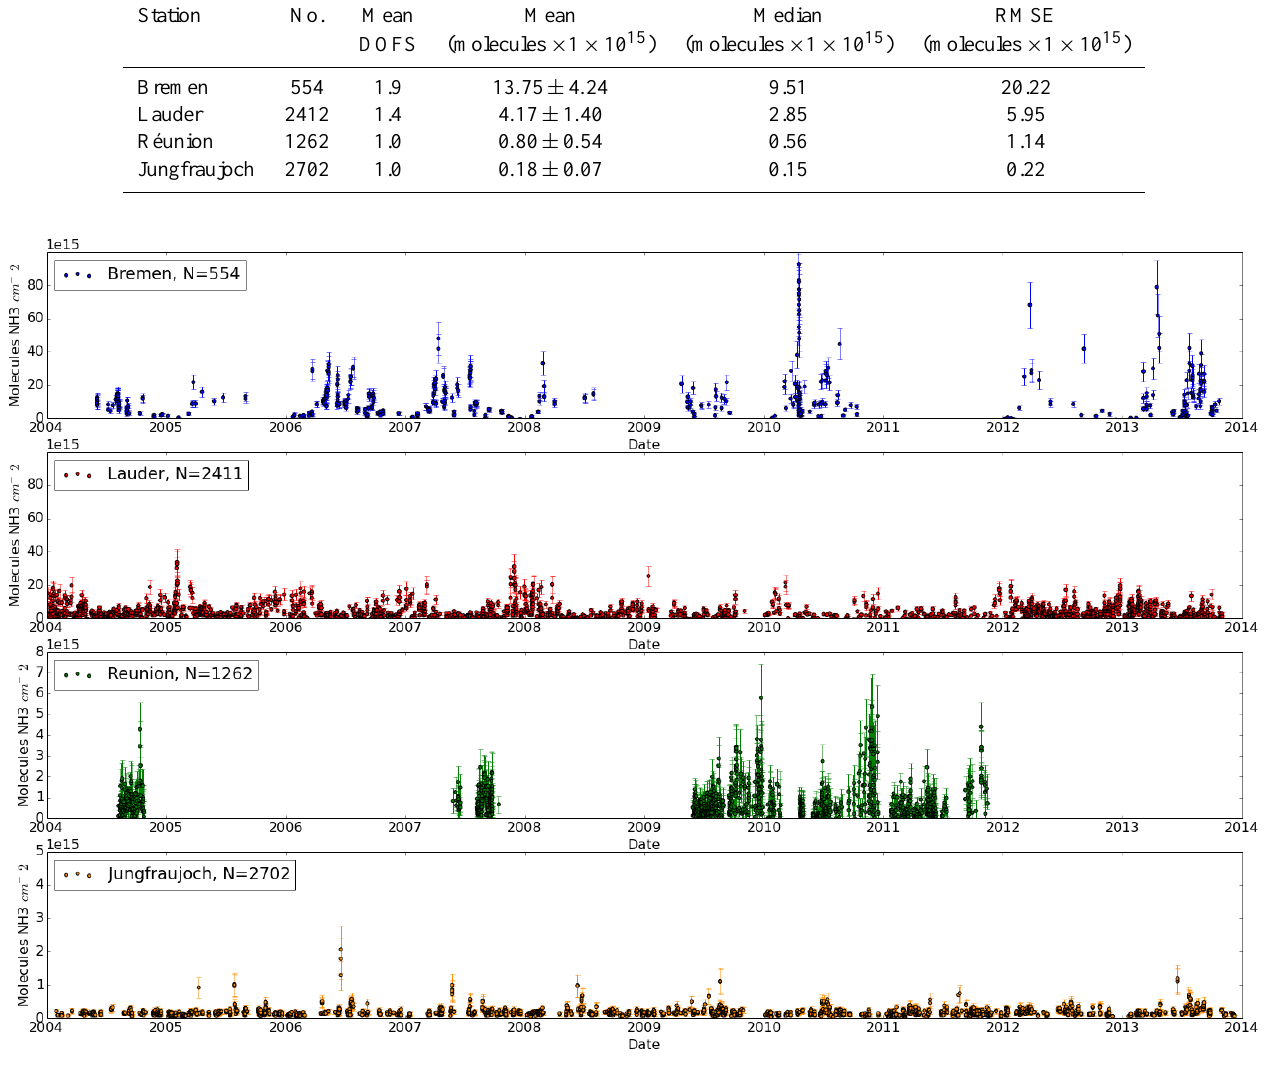
Figure 5. Time series of retrieved NH 3 columns (in molecules NH 3 cm − 2 ) . From top to bottom the figure shows the Bremen (blue), Lauder (red), Réunion (green) and Jungfraujoch (yellow) total columns. The bars reflect the errors in the individual